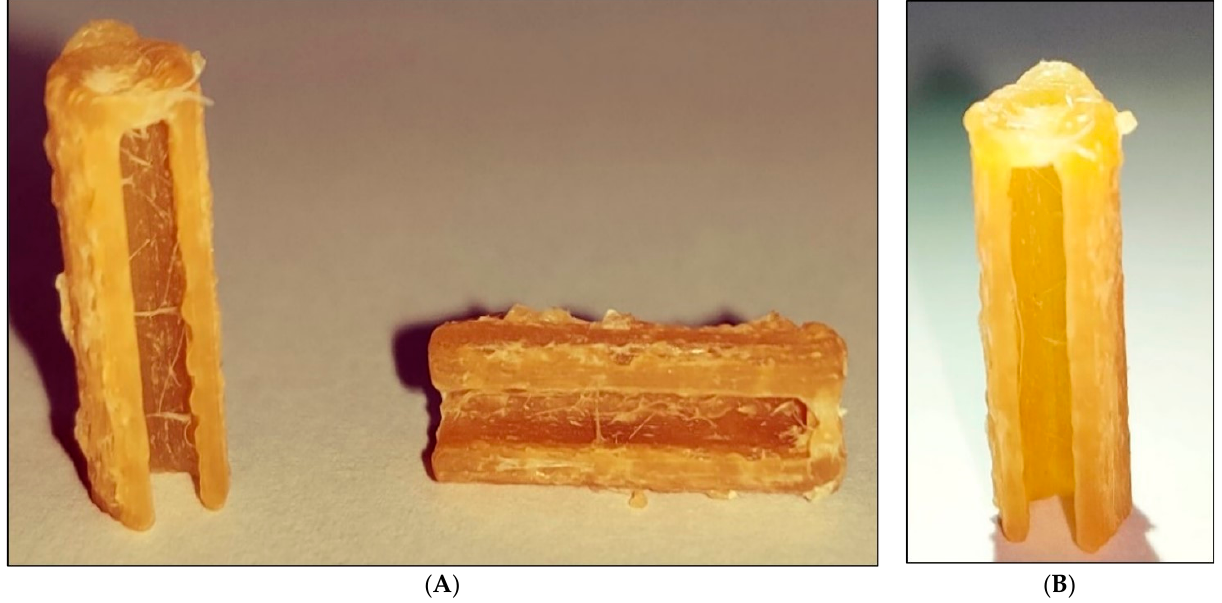
Figure 1. Fused fi lament fabricated 3D sorbent. ( A ) Raw sorbent before activation, vertical and horizontal view, and ( B ) rinsed sorbent after activation. horizontal view, and ( B ) rinsed sorbent after